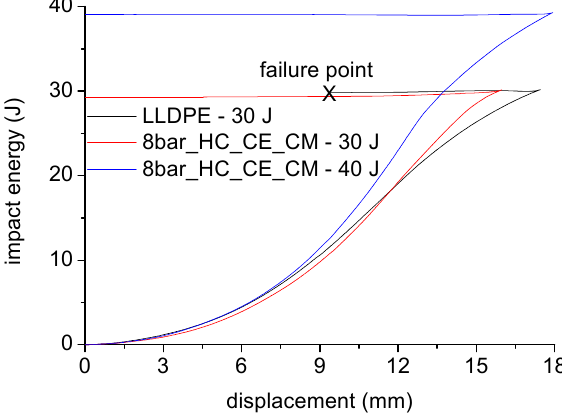
Figure 10. Results of impact tests on reinforced and unreinforced plates.